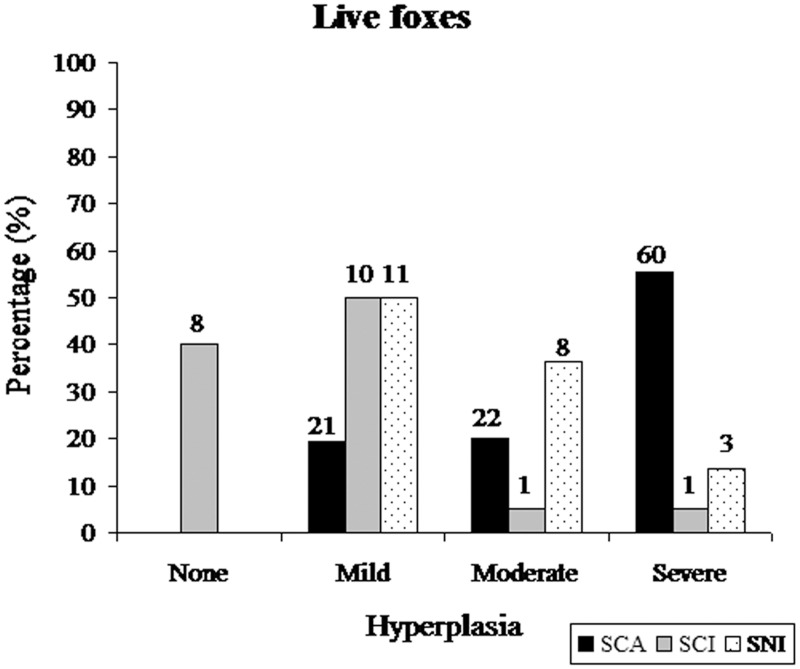
The frequency distribution of ceruminous gland hyperplasia scores in biopsy-sampled live adult foxes from SCA, SCI, and SNI.Number above bar equals sample size for each subgroup.